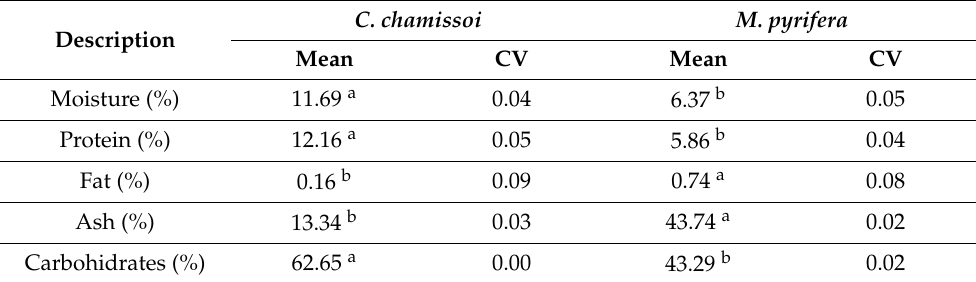
Table 1. Proximal analysis of brown ( M. pyrifera ) and red ( C. chamissoi ) Peruvian seaweed.